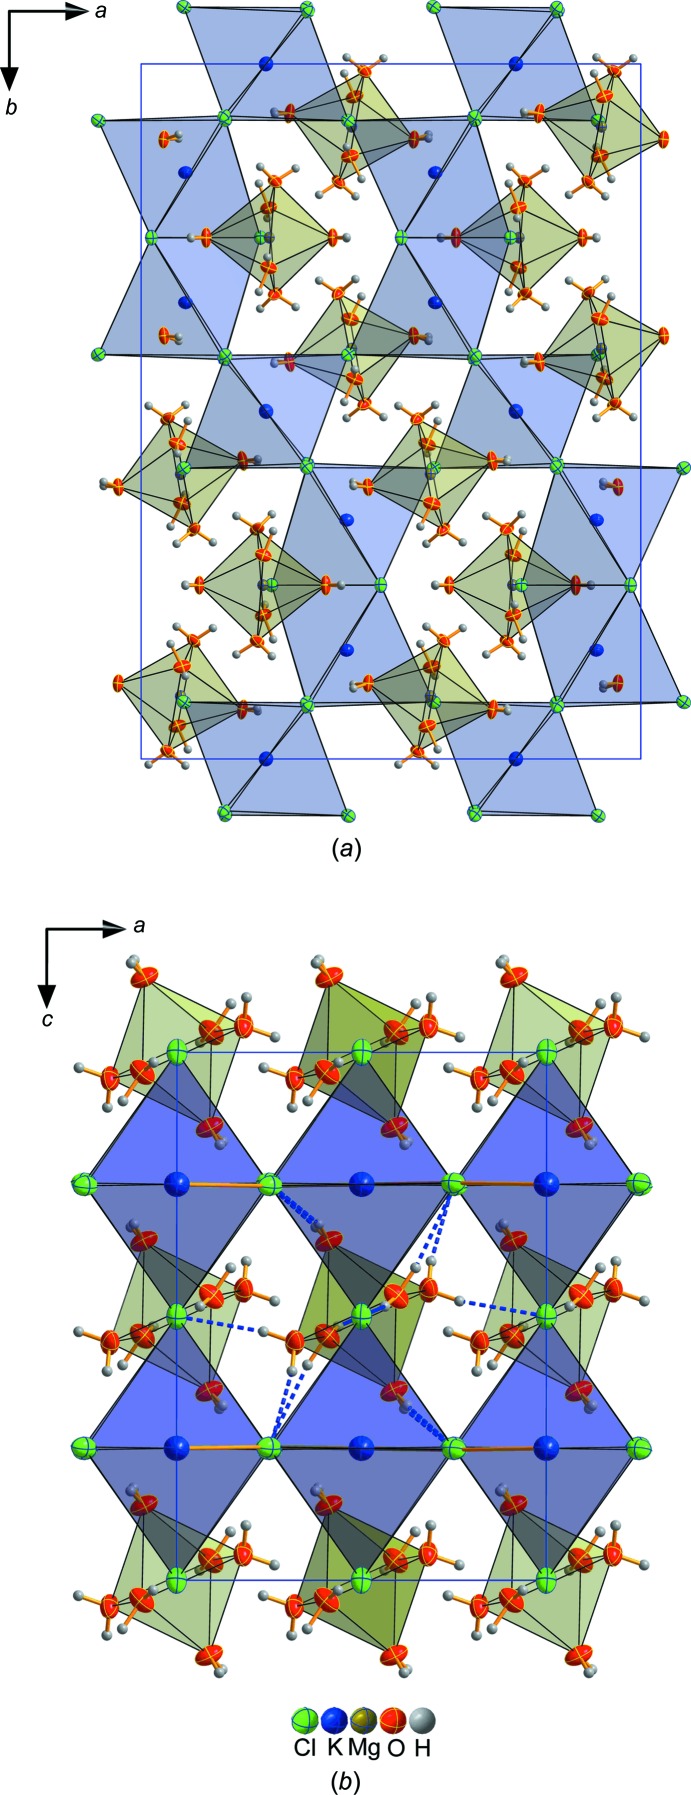
Comparison of the unit cells of (a) ortho­rhom­bic and (b) monoclinic KCl·MgCl2·6H2O.